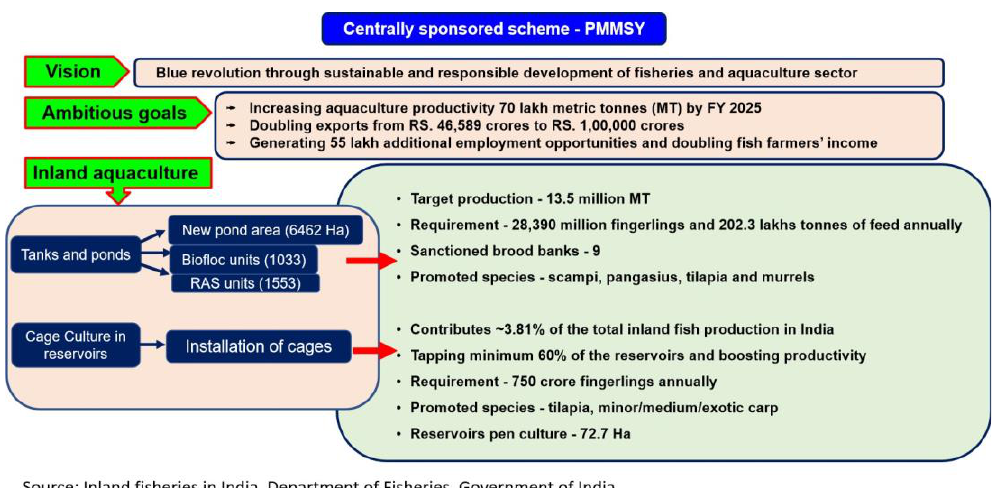
Figure 7. The schematic representation of aims and expected outcomes of centrally sponsored scheme (PMMSY) with the potential to increase aquacultural productivity, exportation, and employment